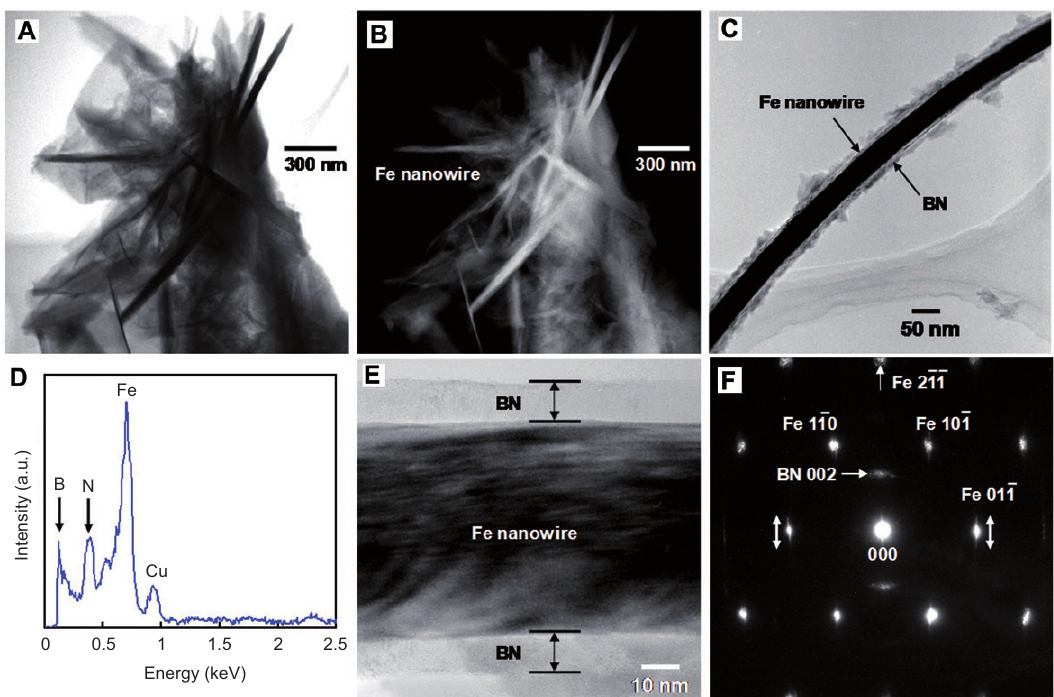
Figure 23 (A) TEM and (B) HAADF images of Fe-fi lled BN nanotubes. (C) TEM image of Fe-fi lled BN nanotube. (D) EDX spectrum of Fe-fi lled BN nanotube. (E) Enlarged image of (C). (F) Electron diffraction pattern obtained from